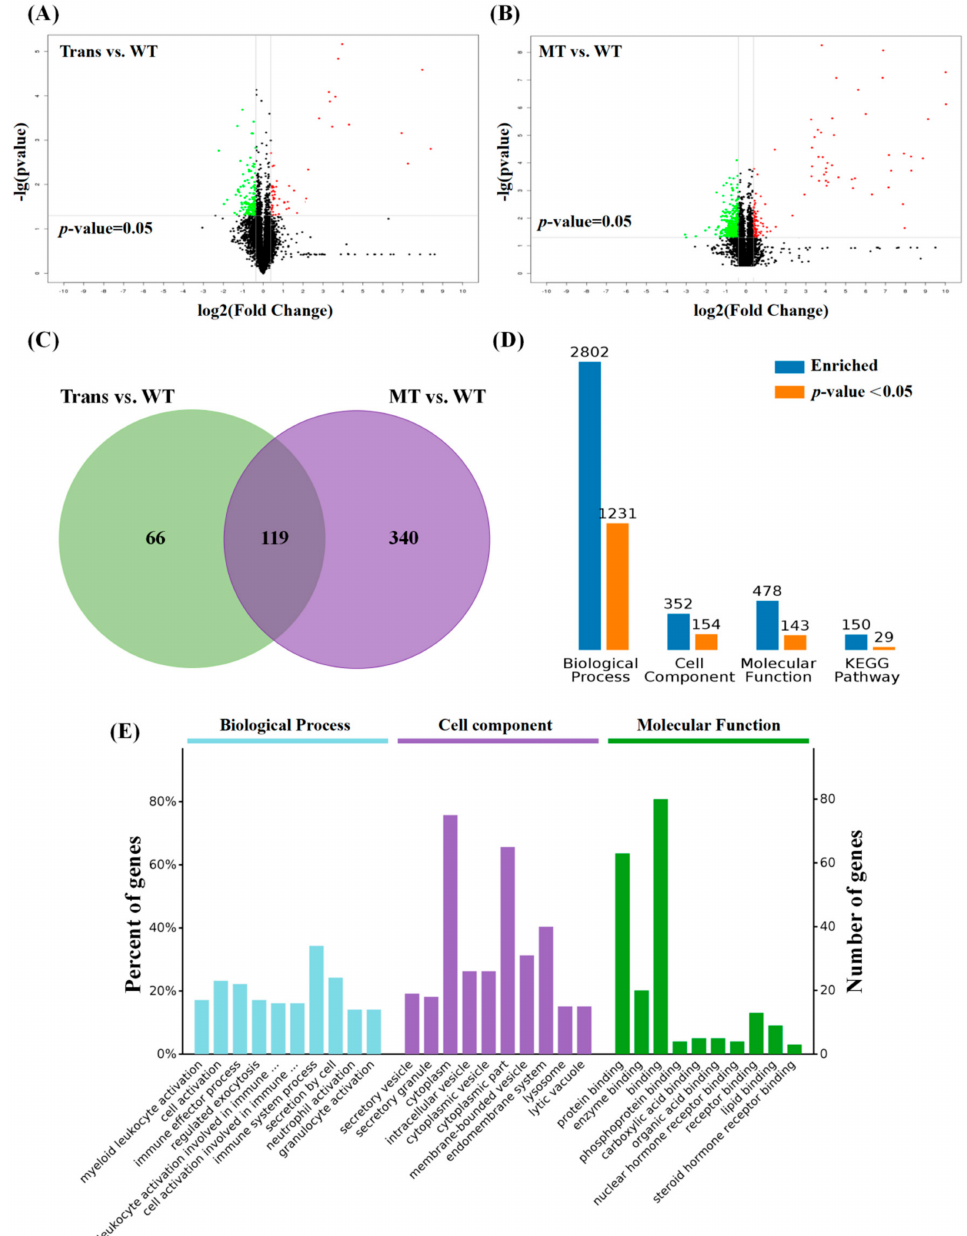
Figure 2. Proteogenomic analysis of the PBMCs from LPS-treated transgenic and WT goats. ( A ) Volcano plot of differential proteins (Trans vs WT): red plot: upregulation; green plot: downregulation; ( B ) volcano plot of differential proteins (WT with MT vs WT): red plot: upregulation; green plot: downregulation; ( C ) venn diagram analysis: overlapping differential expression proteins and unique differential expression proteins respectively identified by Group A (Trans vs WT) and Group B (WT with MT vs WT); ( D ) enriched GO terms and KEGG pathway from Venn diagram analysis of 119 overlapping differential proteins: blue: enriched; orange: significantly enriched; ( E ) protein expression in GO terms. PBMCs: peripheral blood mononuclear cells; LPS: lipopolysaccharide; Trans: transgenic goats; WT: wild-type goats; MT: